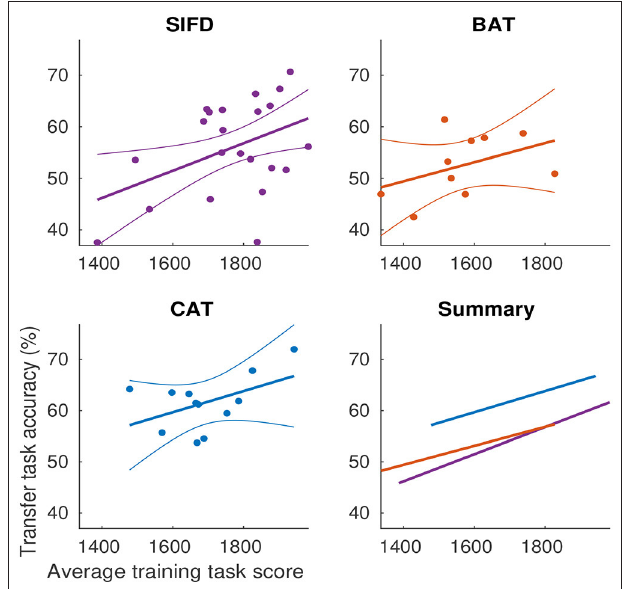
FIGURE 5 | Differences in training task scores do not account for the transfer performance advantage of CAT. Curved lines show 95% confidence intervals of the fit.